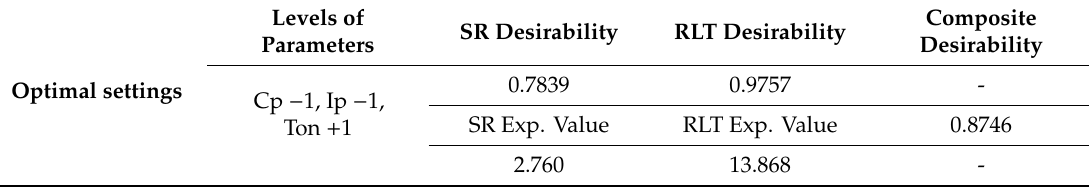
Table 9. Parametric optimization for minimizing SR and